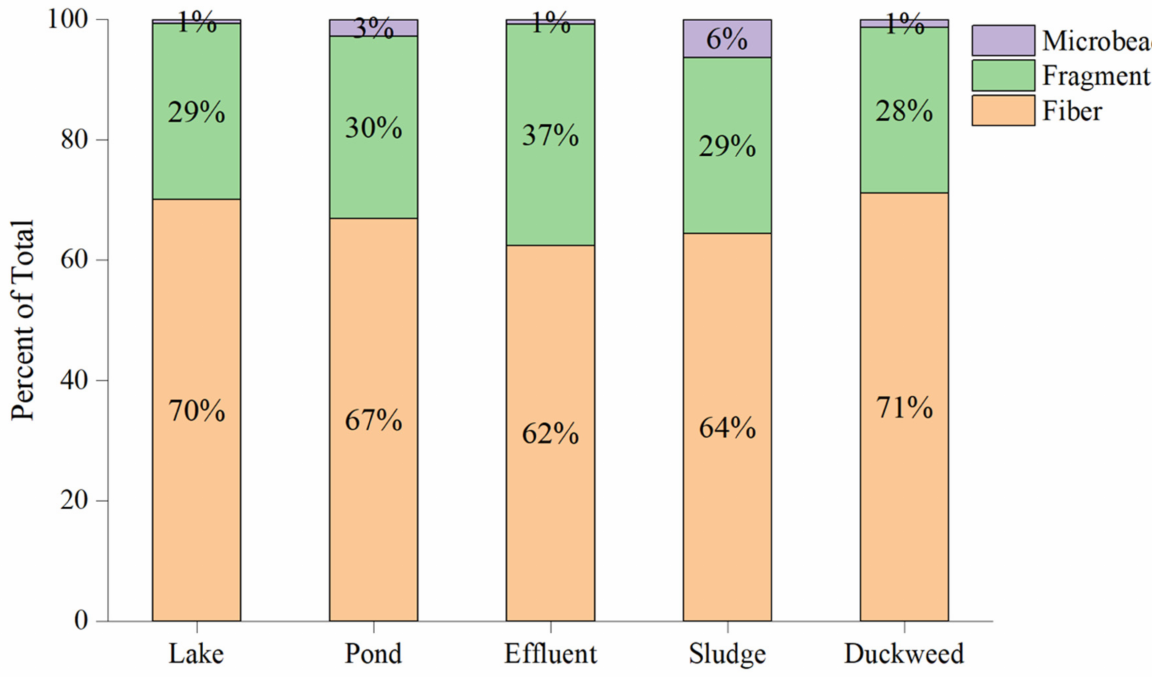
Figure 3. The distribution of microplastic morphologies detected in Wellsgate Lake and the waste stabilization pond (water, effluent, sludge, and